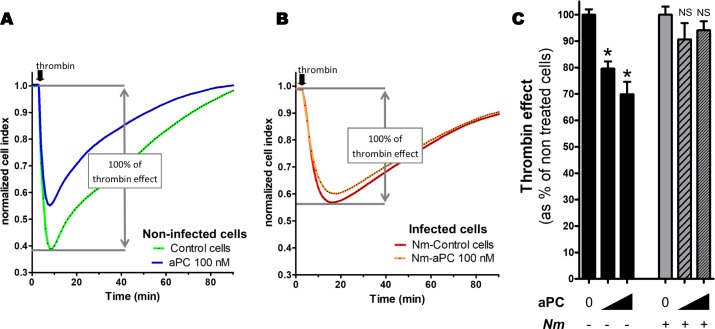
Meningococcal infection suppresses the aPC barrier protective effect.The barrier permeability of HDMEC monolayers was assessed using the iCELLigence system that continuously measures the electrical impedance. Cells were infected with a wild type meningococcus for 4 hours or left non-infected. After the infection, cell media were replaced, and cells were treated with aPC (50 nM or 100 nM) or left untreated. After 2 hours, thrombin (1 nM) was added and electrical impedance (Cell Index) was measured every minutes. (A) Representative data showing the effect of thrombin on monolayers impedance when HDMEC cells were treated (blue) or not (green) with aPC (100 nM). (B) Representative data showing the effect of thrombin on monolayers impedance when HDMEC cells were treated (orange) or not (red) with aPC (100 nM). (C) Loss of CI induced by thrombin expressed as % of non-treated cells. Data are mean (+/-SEM) from three independent experiments. For each condition (non-infected/infected) an analysis of variance (ANOVA) was done followed by multiple comparisons by t-tests with a correction of Bonferonni. *: p <0.01 compared to non-treated cells. NS: non significant (p>0.05).